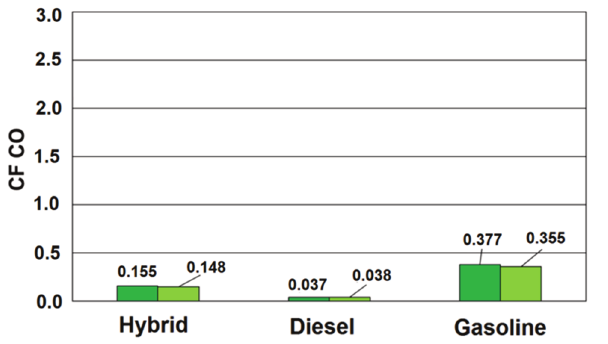
Fig. 15. Values of carbon monoxide emission factors for each of the vehicles in the whole RDE test (EMROAD and all